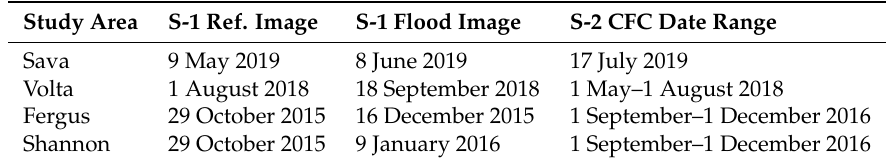
Table 1. Overview of dates/date ranges for the used Sentinel-1 (S-1) and Sentinel-2 (S-2) imagery per study